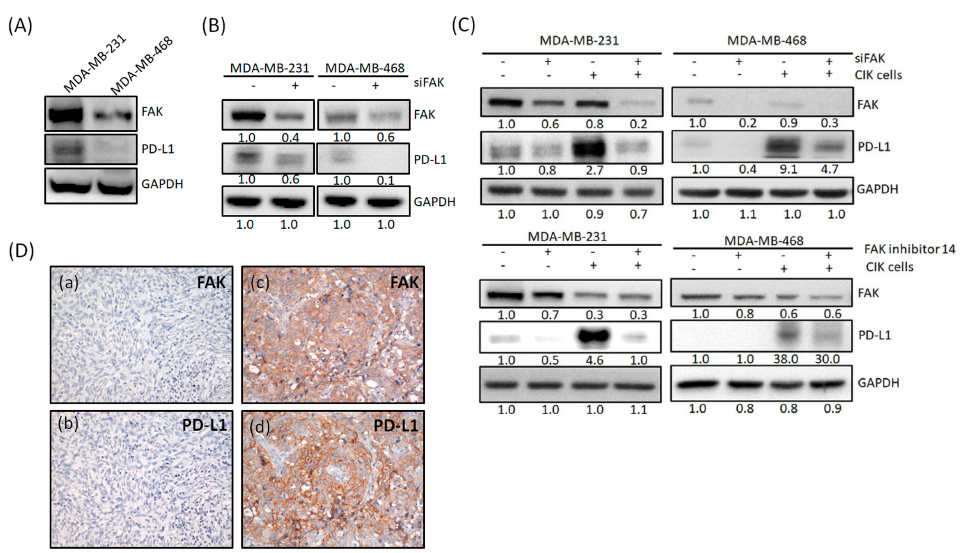
Figure 4. FAK expression is correlated with PD-L1 expression. ( A ) Basal FAK and PD-L1 expression in MDA-MB-231 and MDA-MB-468 cells. ( B ) PD-L1 expression decreased after siRNA-mediated knockdown of FAK expression in MDA-MB-231 and MDA-MB-468 cells. ( C ) MDA-MB-231 and MDA-MB-468 cells cocultured with CIK cells showed upregulated PD-L1 expression, but were inhibited by knockdown of FAK or FAK inhibitor treatment. ( D ) Representative immunostaining results for the expression of FAK and PD-L1 in TNBC tissues. Immunoreactivity of FAK and PD-L1 was classified as negative ( a , b ) or positive ( c , d ) based on staining observed for the cell cytoplasm and membrane. Western blot data were from three independent